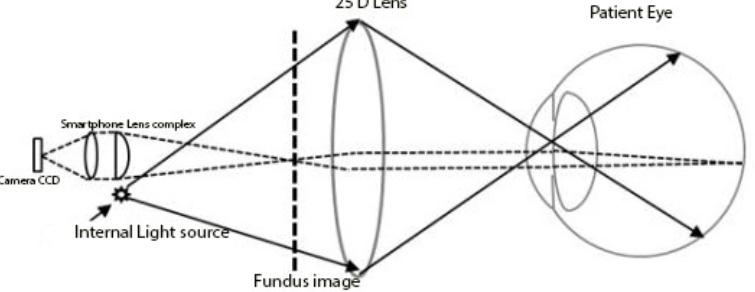
Figure 1. Schematic Drawing Illustrating the Viewing System of the smartphone Retinal Imager. The digital camera has a 25D condensing lens attached to a 21.4-megapixel camera with a built-in lens complex. The smart phone camera’s flash provides the internal light source with a real image created between the 25D lens and smartphone .